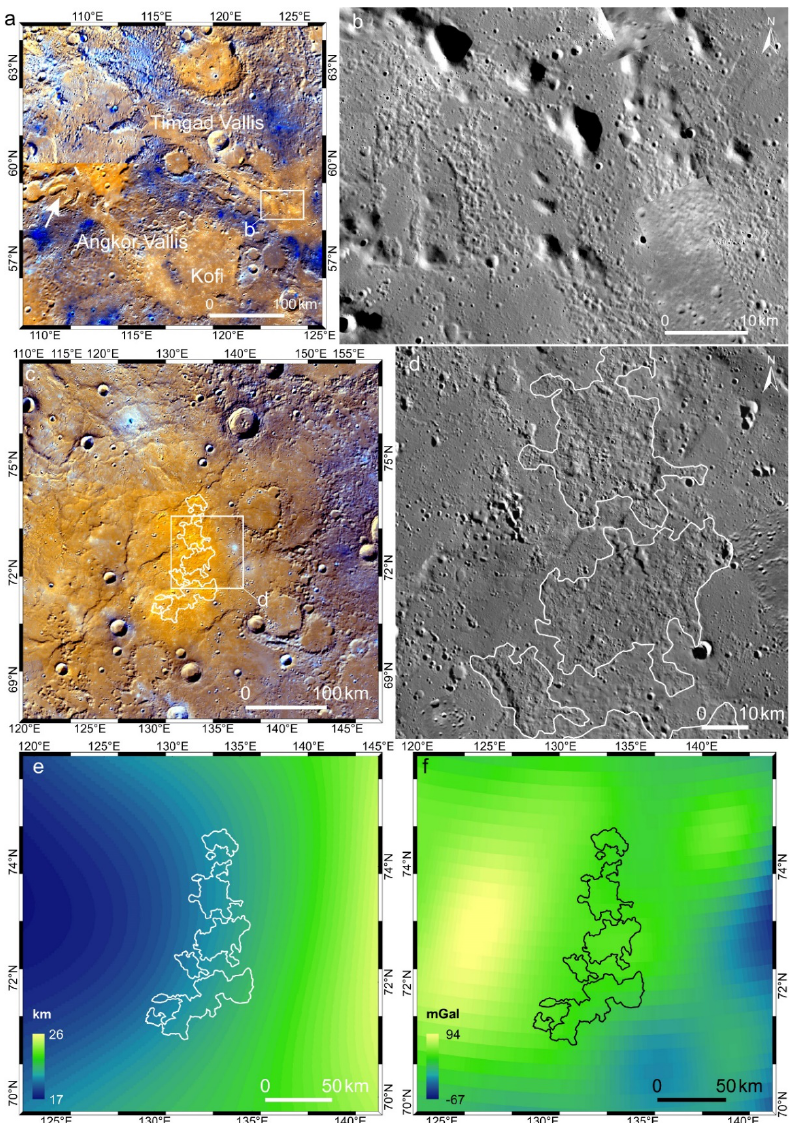
Figure 6. Pitted-ground volcanoes developed in high-reflectance plain materials on Mercury. ( a , b ) Color and monochrome mosaics for the pitted-ground volcano in the lava channel that is connected with the Borealis Planitia. ( c – f ) Color, monochrome mosaics, crustal thickness, and Bouguer gravity anomaly for the only pitted-ground volcano developed in the Borealis Planitia. IDs of the base data used are listed in Table S1.